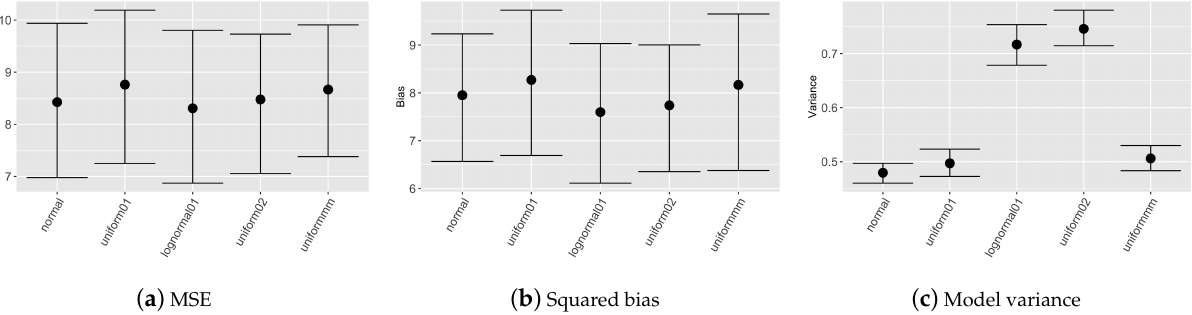
Figure 1. Comparison of nonparametric confidence intervals for MSE, squared bias and model variance related to the validation set for different prior choices on the covariates.